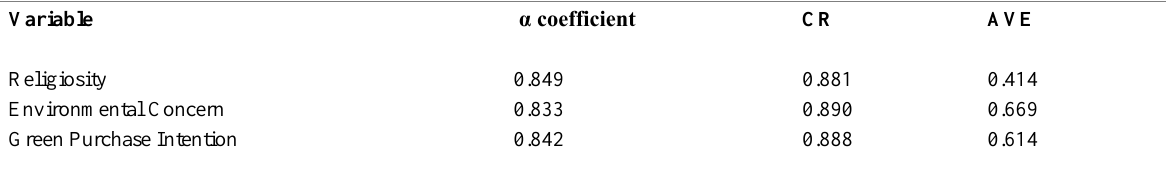
Table 2. Cronbach Alpha’s Value, Composite Reliability, and Average Variance Extracted